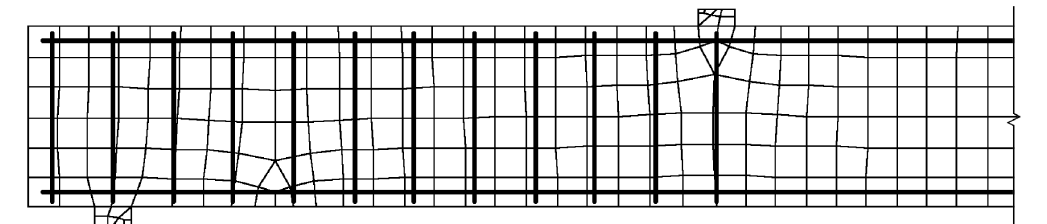
Fig. 10. Comparison of experimental and calculated P-w curves for the experimental beams with 1.0% volume of fibres